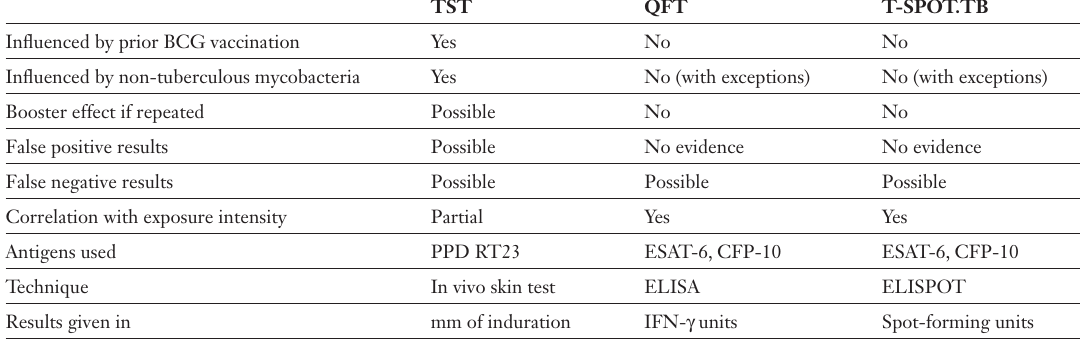
Main similarities and differences between tuberculin skin tests (TST) and T-cell Inter- feron-Gamma Assays (QuantiFERON-TB Gold = QFT and T-SPOT. TB